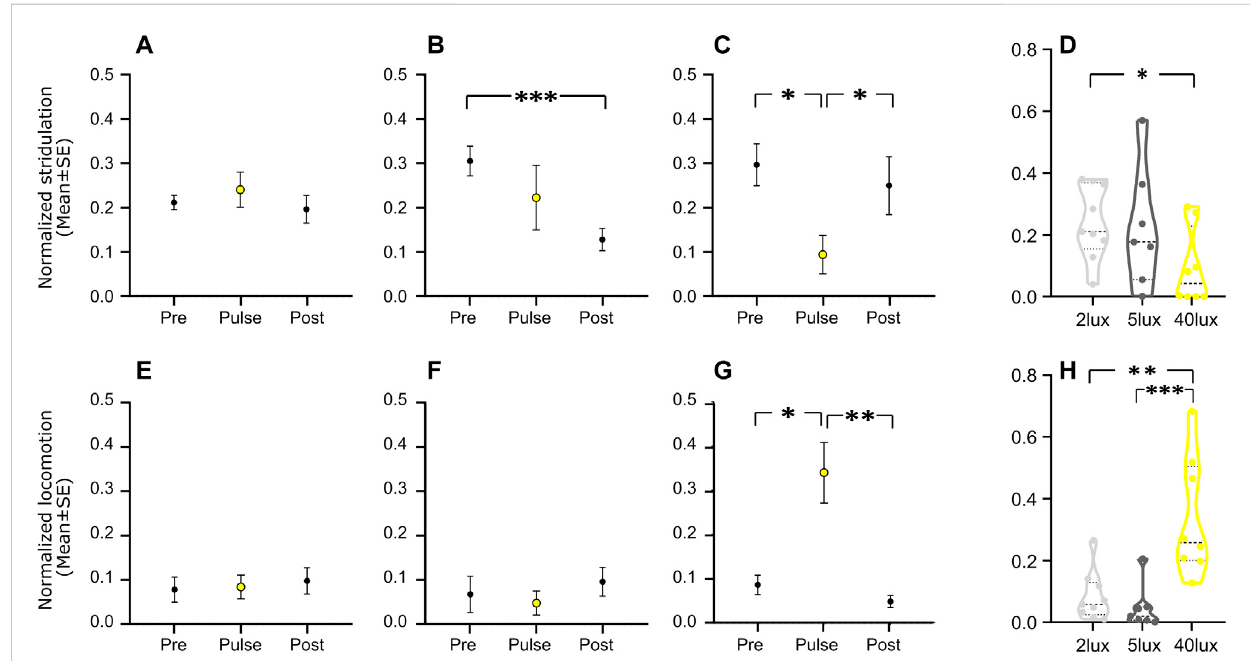
FIGURE 3 Normalized mean level (±s.e.) of stridulation (A – C) and locomotion (E – G) behavior, three nights before ( ‘ Pre ’ ), during the pulse treatment ( ‘ Pulse ’ , yellow),andthreenightsafter( ‘ Post ’ )apulseof2lux( A , E ; n =9),5lux( B , F ; n =8),and40lux( C , G ; n =8). (D – H) Thenormalizedmeanbehaviorlevels( D , stridulation; and H , locomotion) during the pulse treatment under the different pulse intensities. * p < 0.05, ** p < 0.01, *** p < 0.001.